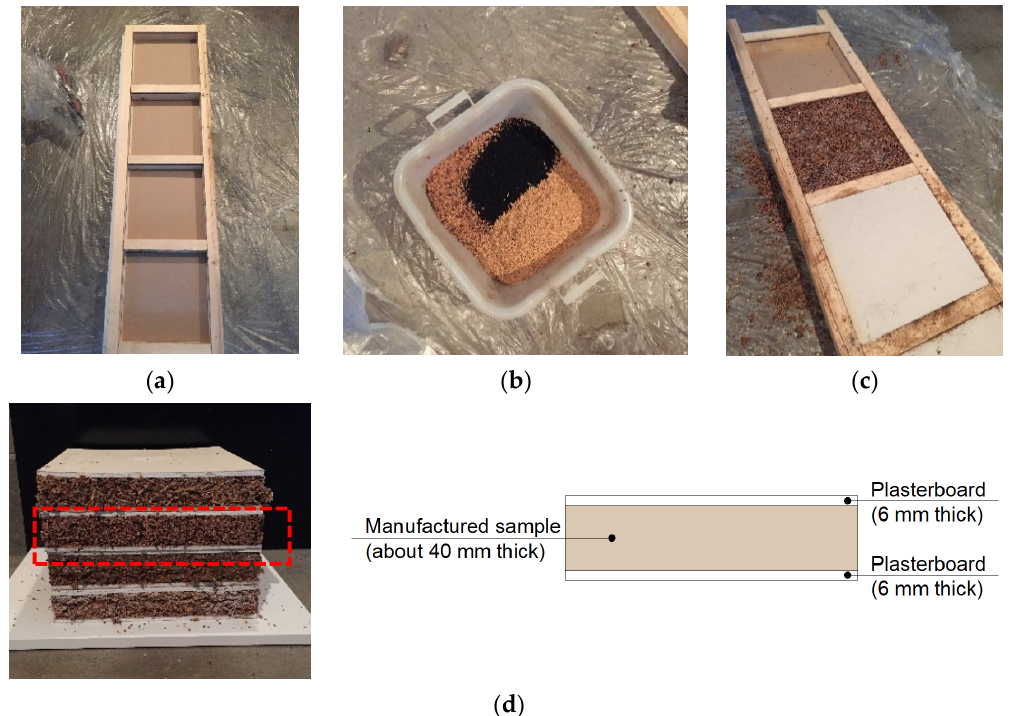
Figure 1. Different steps for the manufacturing of the samples: ( a ) formworks for the samples; ( b ) mixing phase of the loose materials; ( c ) positioning of the materials with glue in the formworks; ( d ) final panels and schematic section of a single sample.